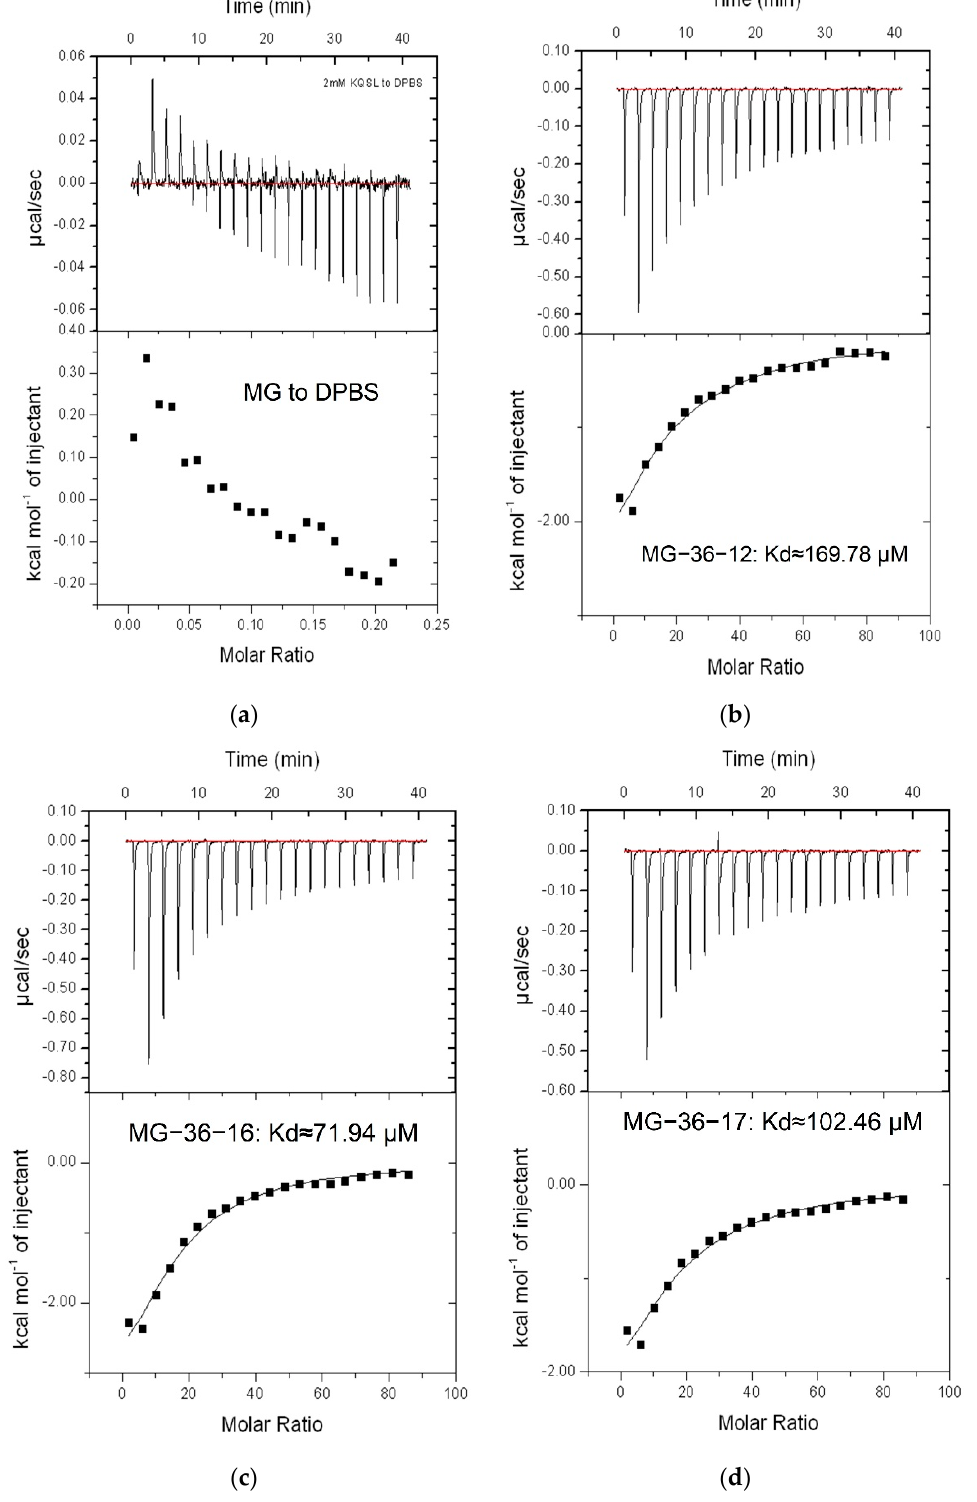
Figure 2. ITC analysis of binding dissociation constants (K d ). ( a ) 2 mM MG oxalate standard solution to DPBS. ( b – d ) The saturation curves and K d of aptamer MG-36-12, MG-36-16, and MG-36-17 were obtained by ITC analysis.